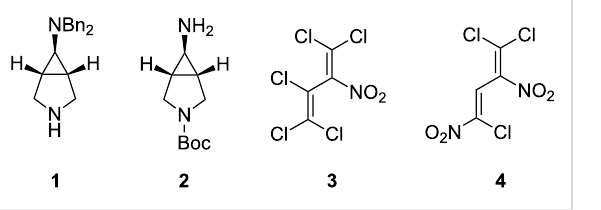
Figure 1: Promising starting materials for biologically active com- pounds.